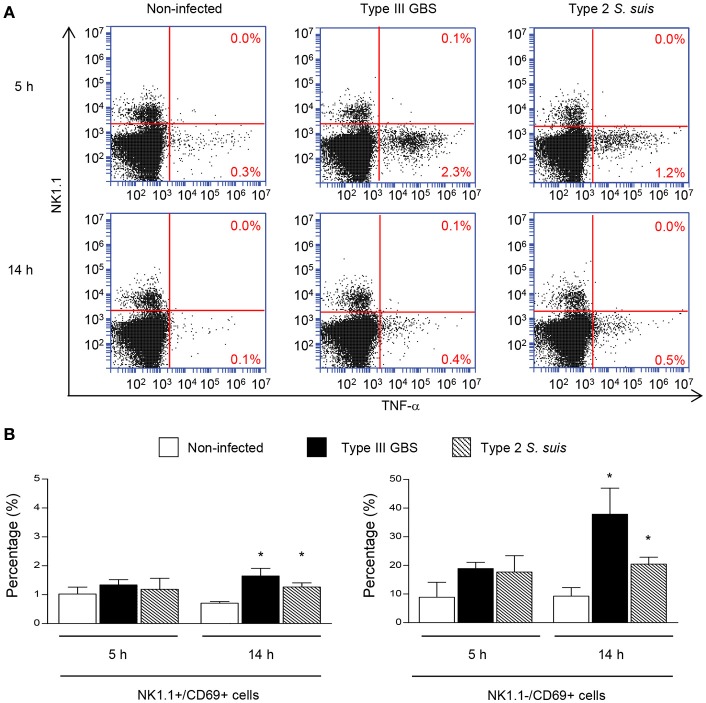
TNF-α production and CD69 expression by NK1.1+ cells during the acute phase of streptococcal infections. Mice were infected intraperitoneally with a dose of 1 × 107 of type III GBS wild-type strain COH-1 or 5 × 107 CFU of type 2 S. suis wild-type strain P1/7 (n = 3 per group × 3 individual experimental infections). Spleens were harvested 6 h post-infection and total splenocytes plated at 5 × 106 cells/well. Non-stimulated cells from mock-infected animals served as negative control for basal expression (Non-infected). Total splenocytes were incubated for 5 or 14 h with brefeldin A (3 μg/ml) added during the last 5 h of incubation. Cells were harvested and intracellularly stained for TNF-α (A) or surface stained for CD69 (B) in combination with NK1.1 surface staining. (A) % of TNF-α+ cells within the NK1.1− and the NK1.1+ cell populations are indicated. Representative data from three different experimental infections. (B) % of CD69+ cells within the NK1.1+ or the NK1.1– cell populations of the spleen. Data are expressed as means ± SEM from three different experimental infections. *P < 0.05, indicates statistically significant difference compared to non-infected control mice.